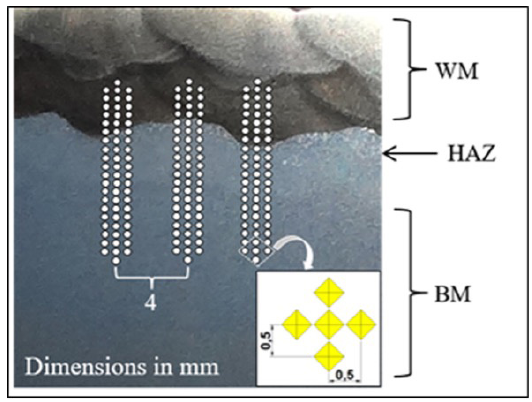
Figure 3. Distribution of indentations in the microhardness test.